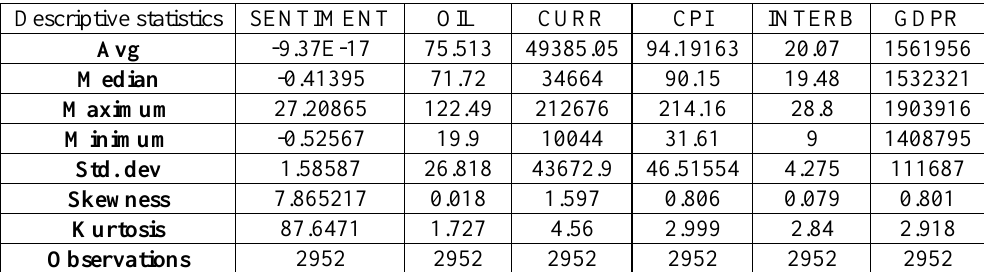
Table 1. Descriptive